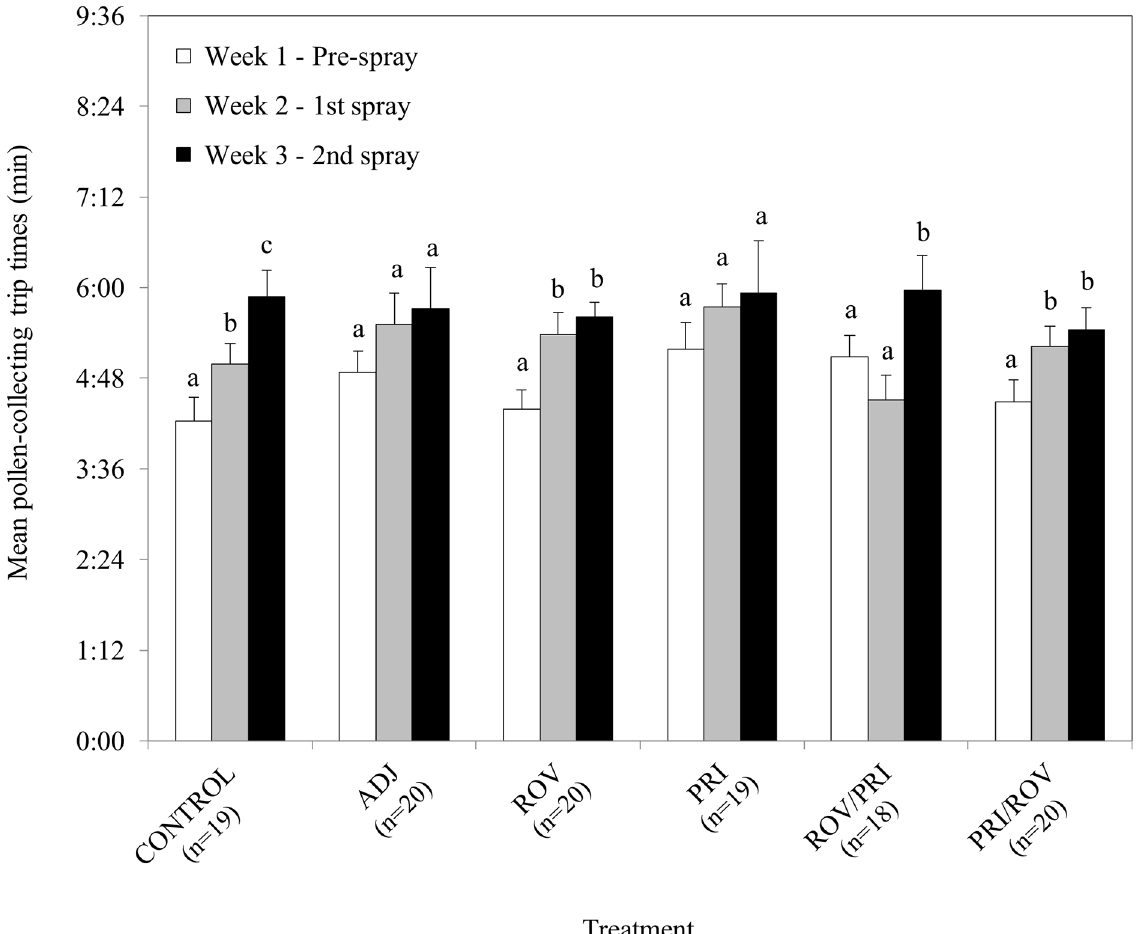
Fig 1. Mean pollen-collecting trip times by Osmia lignaria females before and after treatment applications. Means within each treatment with different letters are significantly different ( P < 0.05).